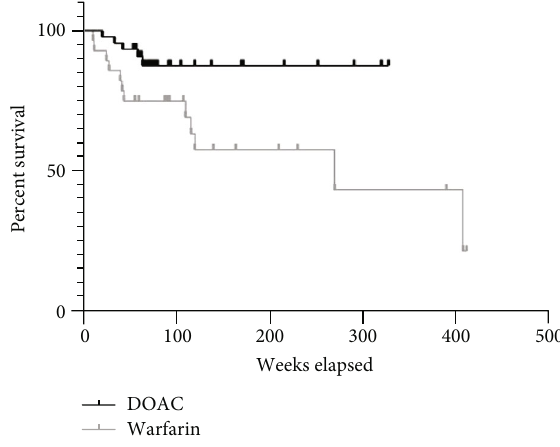
Figure 1: Survival proportions in the two study